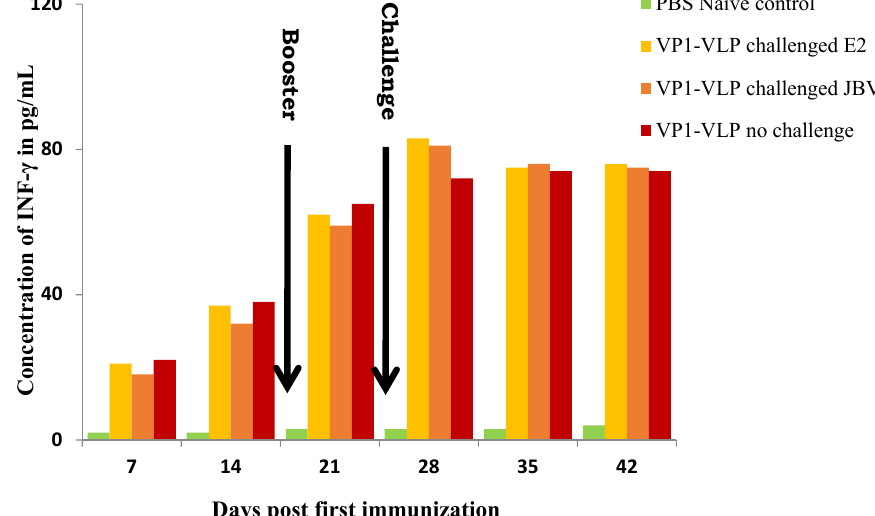
Figure 6. Measuring of IFN- γ by ELISA in the sera of the three different immunized groups. Sera of the mice group were collected at different days post the first immunization (as described in Section 2). The concentrations of IFN- γ were evaluated and measured by ELISA method. PBS naïve mice group represents the control group.